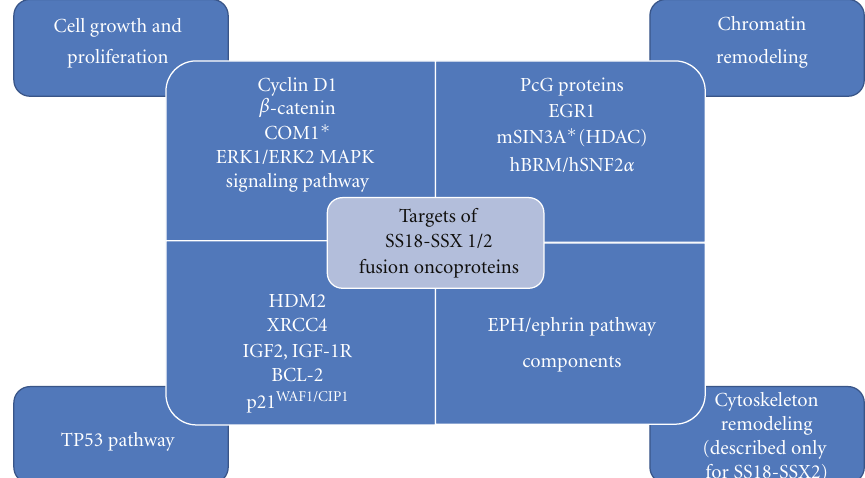
Figure 2: Targets of SS18-SSX1/2 fusion oncoproteins involved in cell growth and proliferation, TP53 pathway, chromatin remodeling, and cytoskeleton remodeling, which may contribute to synovial sarcoma tumorigenesis. COM1-candidate of metastasis protein 1; PcG- polycomb group proteins; EGR-early growth response protein 1; mSIN3A-transcriptional regulator; HDAC-histone deacetylase complex; hBRM/hSNF2 α -chromatin remodeling complex; TP53-tumor protein p53; HDM2-Mdm2 p53 binding protein homolog (mouse); XRCC4- X-ray repair complementing defective repair in Chinese hamster cells 4; IGF2-insulin-like growth factor 2; IGF-1R-insulin-like growth factor 1 receptor; BCL-2-B-cell CLL/lymphoma 2. ∗ Only COM1 and mSIN3A have been described to interact directly with SS18-SSX1/2 fusion